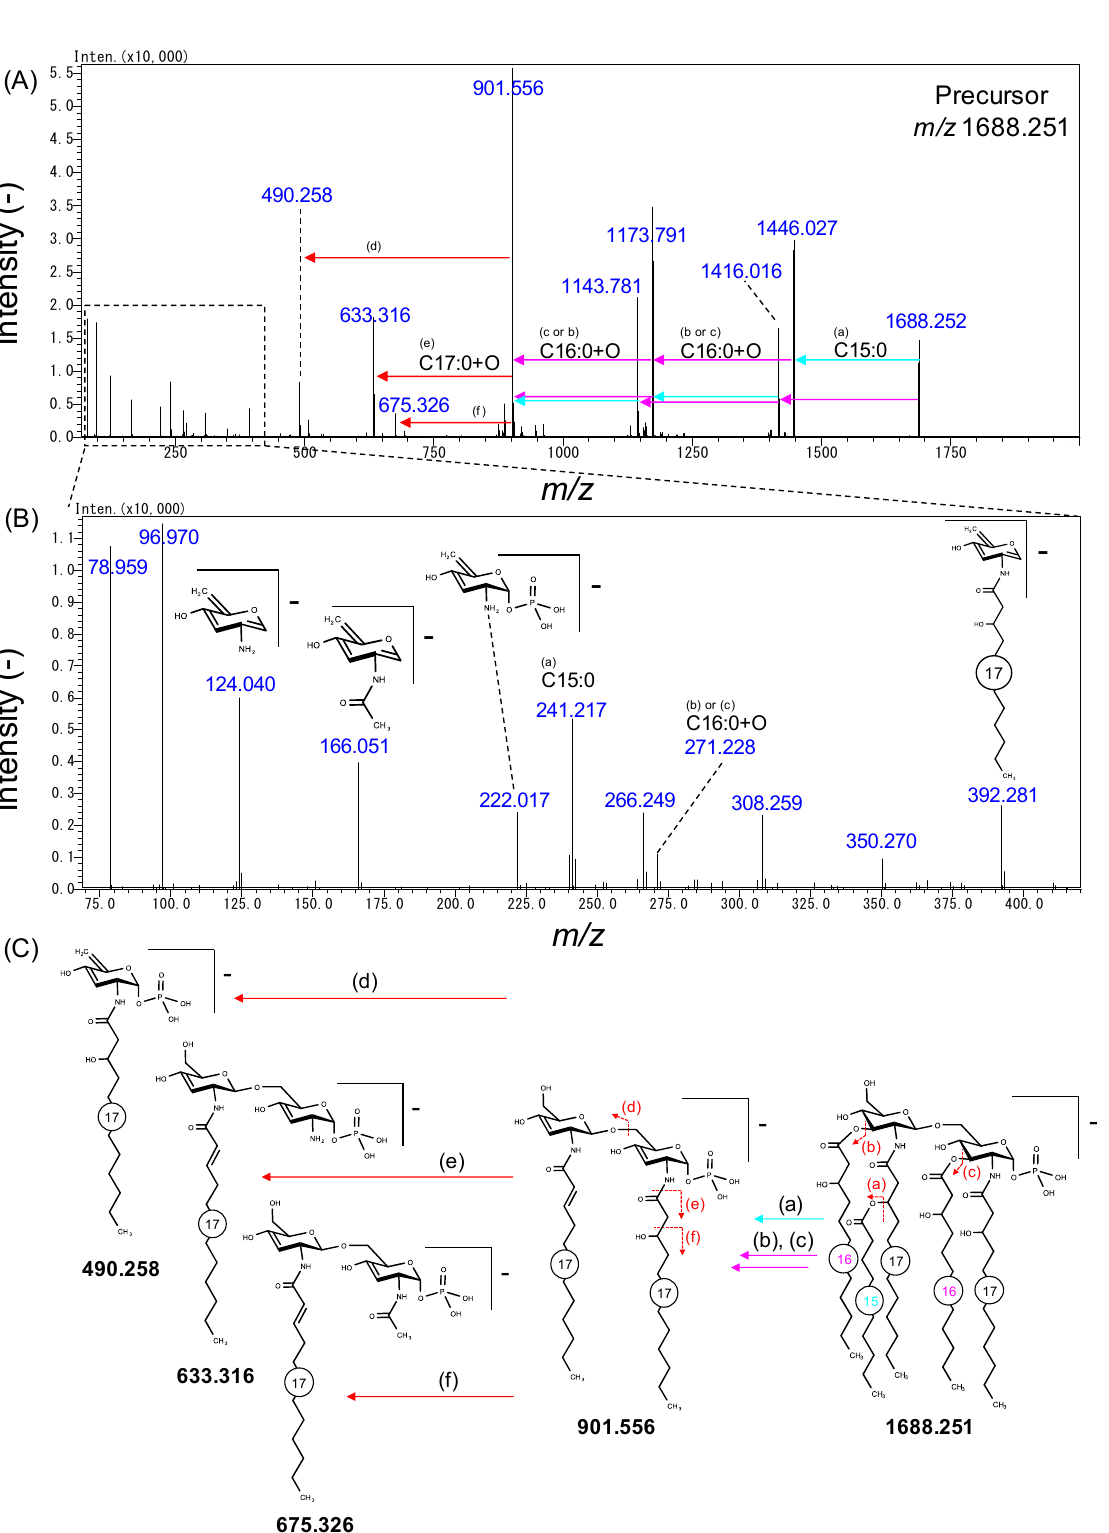
Figure 5. Structural estimation of B. fragilis lipid A. ( A ) MS/MS spectrum of 1688.251. Monoisotopic m/z are given. Arrows indicate the neutral losses. ( B ) Zoomed spectrum of the dashed region shown in ( A ). Estimated fragment ion structures are presented. ( C ) A proposed fragmentation scheme of 1P5A lipid A 81:0. The numbers in circles on acyl chains indicate the chain lengths. ( a )–( f ) correspond to the cleavage sites in the chemical structure of ( C ).